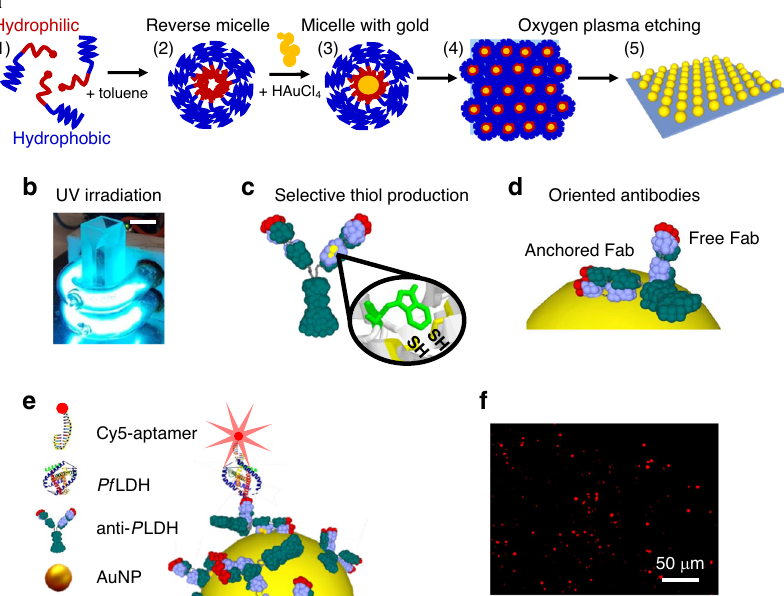
Fig. 1 Operating principle of the device. a Fabrication process of AuNP array by BCMN: (1) dispersion of diblock copolymers with amphiphilic character in toluene solution; (2) formation of reverse micelles with hydrophilic core and outer hydrophobic shell; (3) loading of the gold precursor inside the micelles; (4) sticking of the PS-AuNPs on the substrate through hydrophobic interaction; (5) immobilization of the AuNPs on the substrate after copolymer etching. b Low pressure mercury U-shaped UV lamps used to carry out the biofunctionalization of AuNPs with antibodies through PIT. A standard 10 mm cuvette can be easily housed inside the internal volume (the length of the scale bar in the top-right corner is 1 cm). Given the proximity of the cuvette to the lamps and the wrapping geometry, we estimated that the solution was exposed to an UV-irradiation of 0.3 W/cm 2 . c UV irradiation of the Abs leads to the production of four thiol groups (two of them are not visible in the fi gure). d The position of the thiols, opposite with respect to the plane containing the antibody Fabs, allows to immobilize the Abs with one of their binding sites exposed to the surrounding environment. e Sketch of the Ab- Pf LDH-aptamer sandwich scheme used throughout the experiments. The adoption of Abs as bottom receptor layer and aptamers as top layer allows the fl uorophore to be placed at a distance of approximately 10 nm from the surface. f Example of fl uorescence picture acquired at 1 pM (35 pg/mL) Pf LDH concentration. The red spots arise from the fl uorescence emitted by a single Cy5